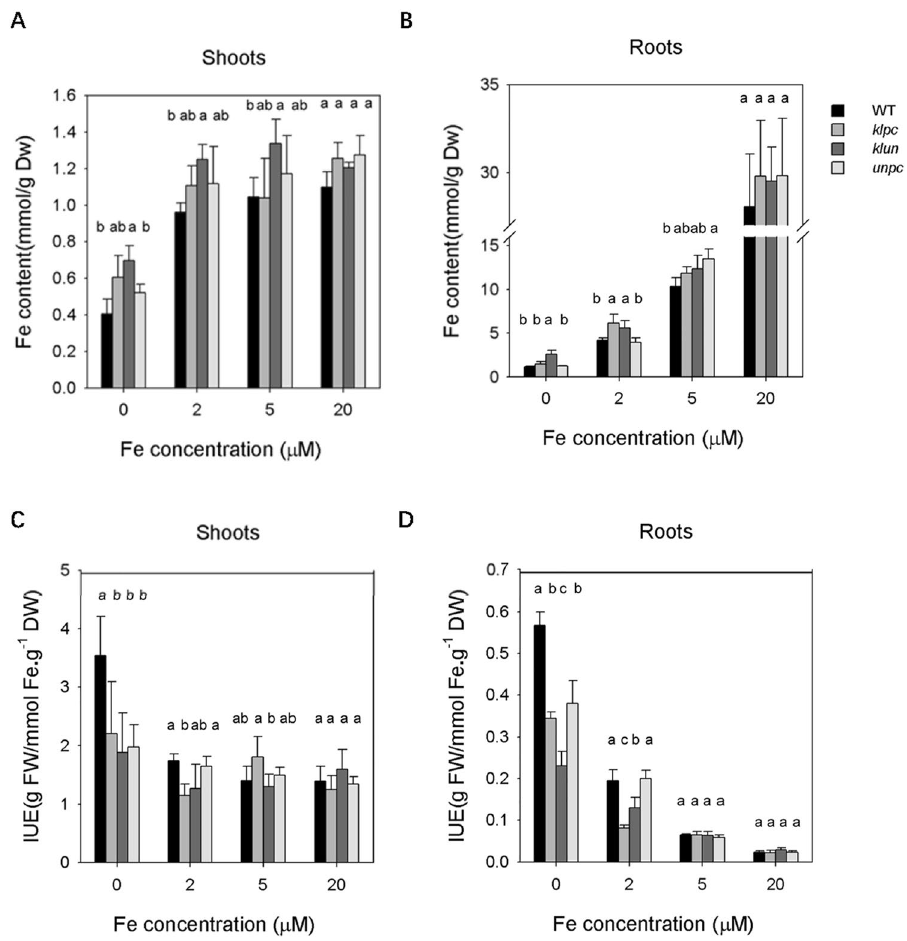
Figure 3. Fe content of shoots and roots of WT and 14-3-3 qKOs plants. After two weeks of growth on ½ strength Hoagland solution, plants were grown for an additional 12 days at 0, 2, 5 and 20 μM (= sufficient) Fe. Shoots and roots were harvested, weighed and pooled per two for the Fe-determination. ( A ) and ( B ), Fe-content of roots and shoots; ( C ) and ( D ), Iron Use Efficiency (IUE) of roots and shoots. Values are means ± SD (n = 5). Different letters above the column indicate that the values are significantly different at p < 0.05 according to Tukey’s